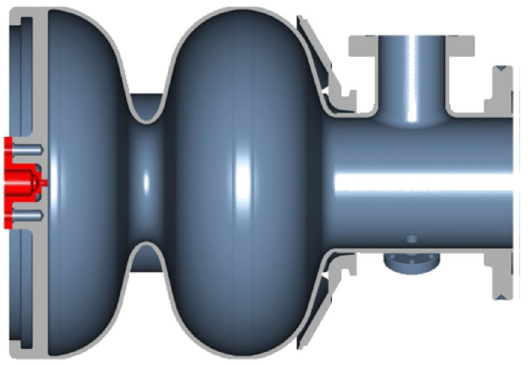
Figure 2. DESY SRF Gun cavity and its superconducting cathode plug [12].